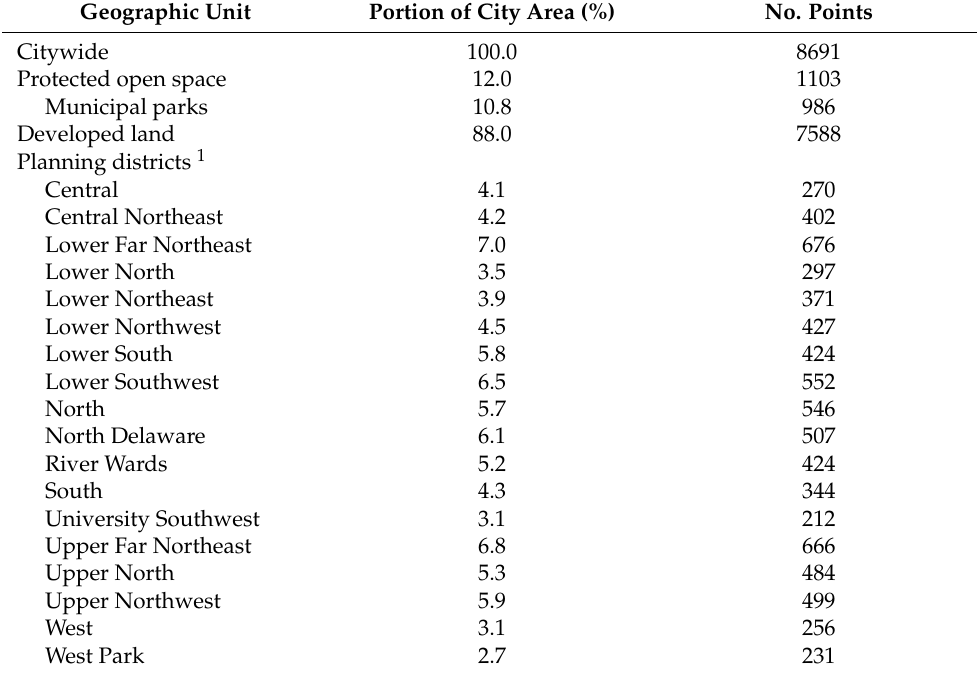
Table 2. Portion of city area and number of points for the geographic units used in this study. Analyses for planning districts include only developed land in each district. Geographic Unit Portion of City Area (%) No. Points Citywide 100.0 8691 Protected open space 12.0 1103 Municipal parks 10.8 986 Developed land 88.0 7588 Planning districts